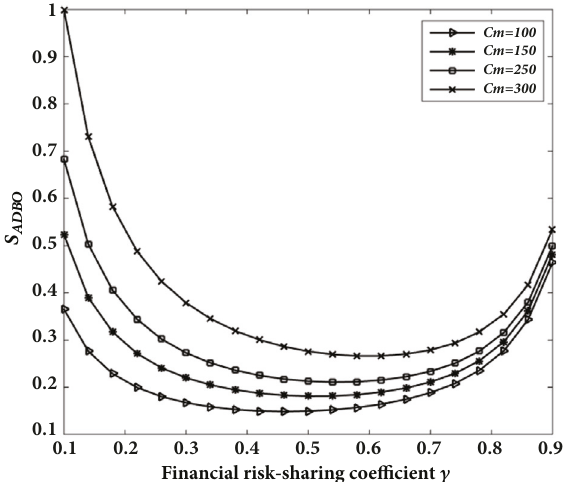
Cm=100 Cm=150 Cm=250 Cm=300